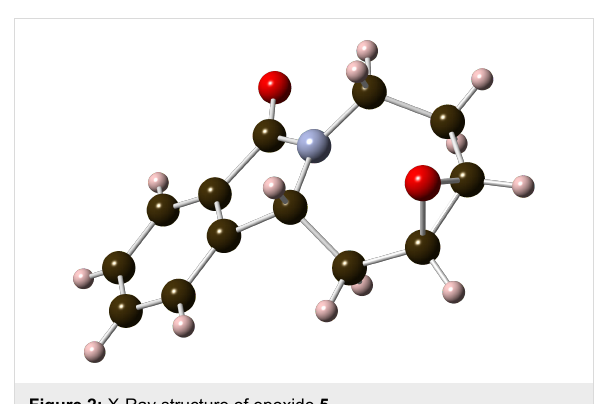
Figure 2: X-Ray structure of epoxide 5